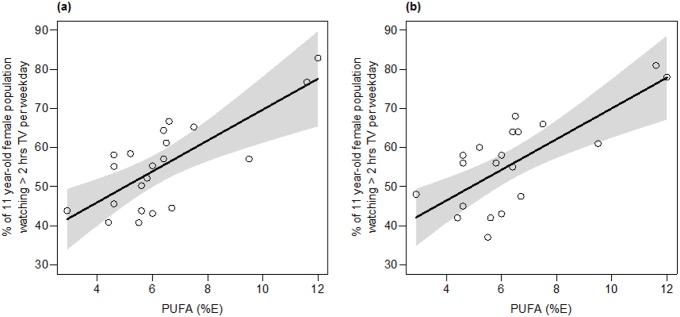
Partial regression plot (a) showing the association between sedentary behaviour of 11 year old girls and mean PUFA, holding all other predictors in the multiple regression constant (N = 21; P< 0.001). Grey shading indicates confidence bands around the regression line (see Table 4A for details). Shown in panel (b) is the least-squares regression betweensedentary behaviour of 11 year old girls and mean PUFA, without any other predictors. The regression is highly significant (N = 21; R2adj = 0.50; P = 0.002).